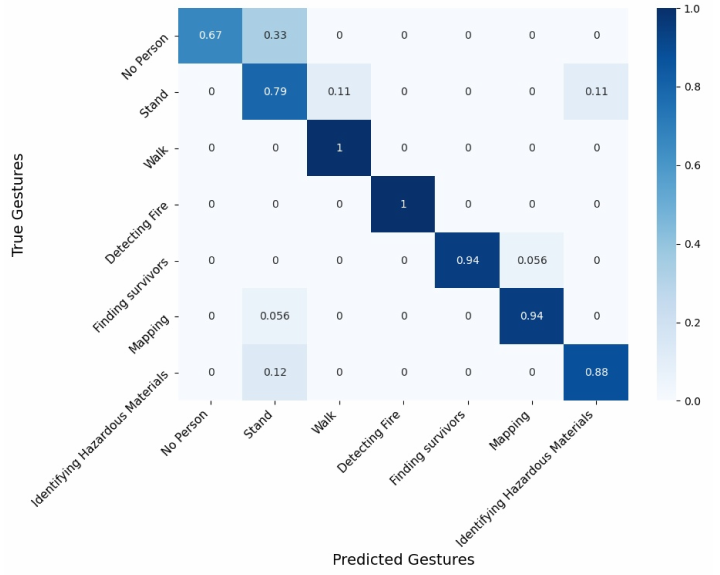
Figure 9. Confusion matrix for the depth sensor with HOG + SVM, without smoke, and without equipment.